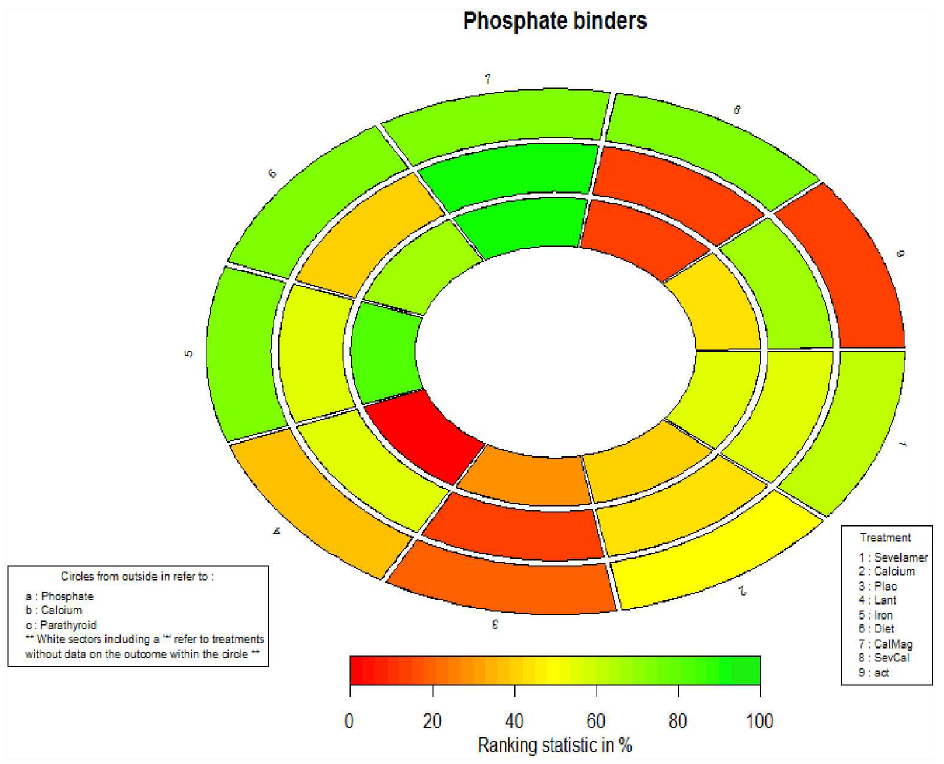
Fig 5. Rank-heat plot of the phosphate binder network for laboratory